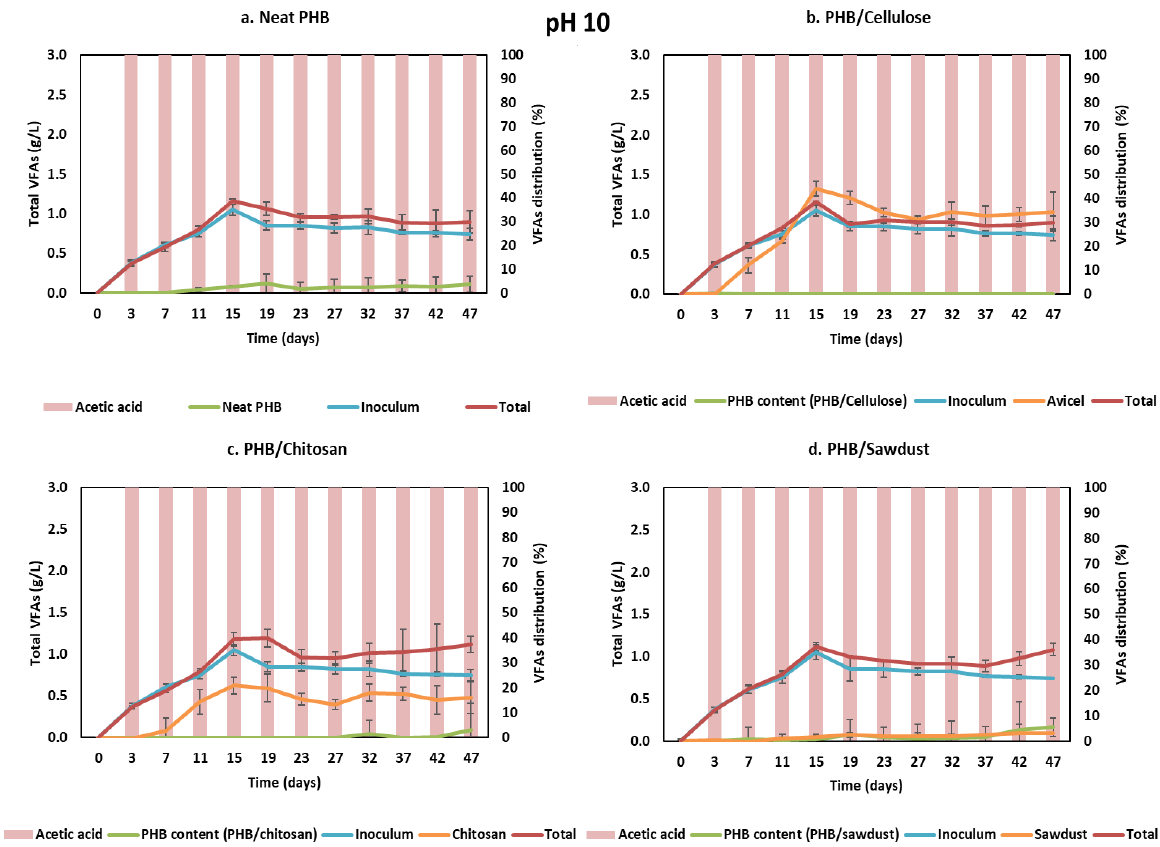
Figure 3. Concentration and percentage distribution of VFAs during acidogenic fermentation of neat PHB ( a ) and PHB composites of PHB/cellulose ( b ), PHB/chitosan ( c ), and PHB/sawdust ( d ) at pH 10. Table 3. The final pH of each sample at pH levels 6 and 10 after acidogenic fermentation.